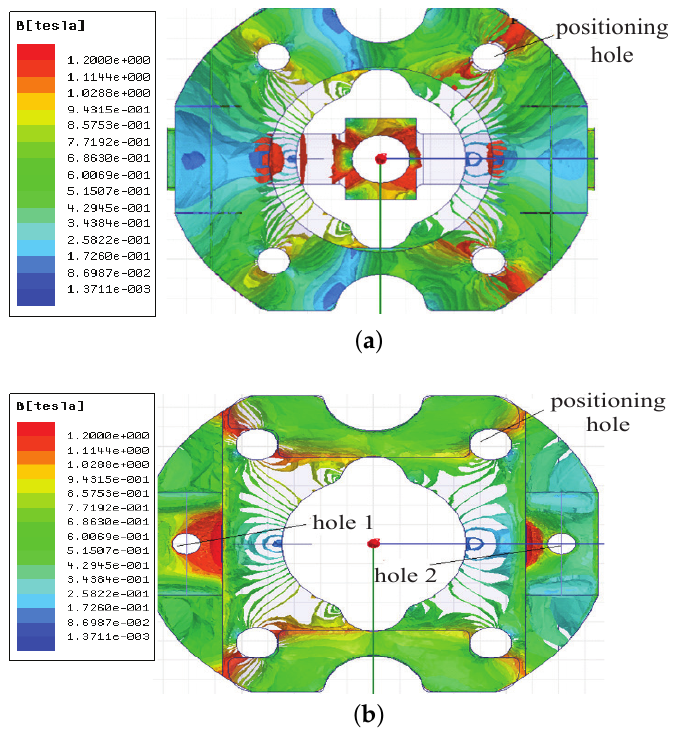
Figure 7. Magnetic saturation in the hydraulic torque motor at I = 20 mA. ( a ) Magnetic field distribution of upper iron block. ( b ) Magnetic field distribution of lower iron